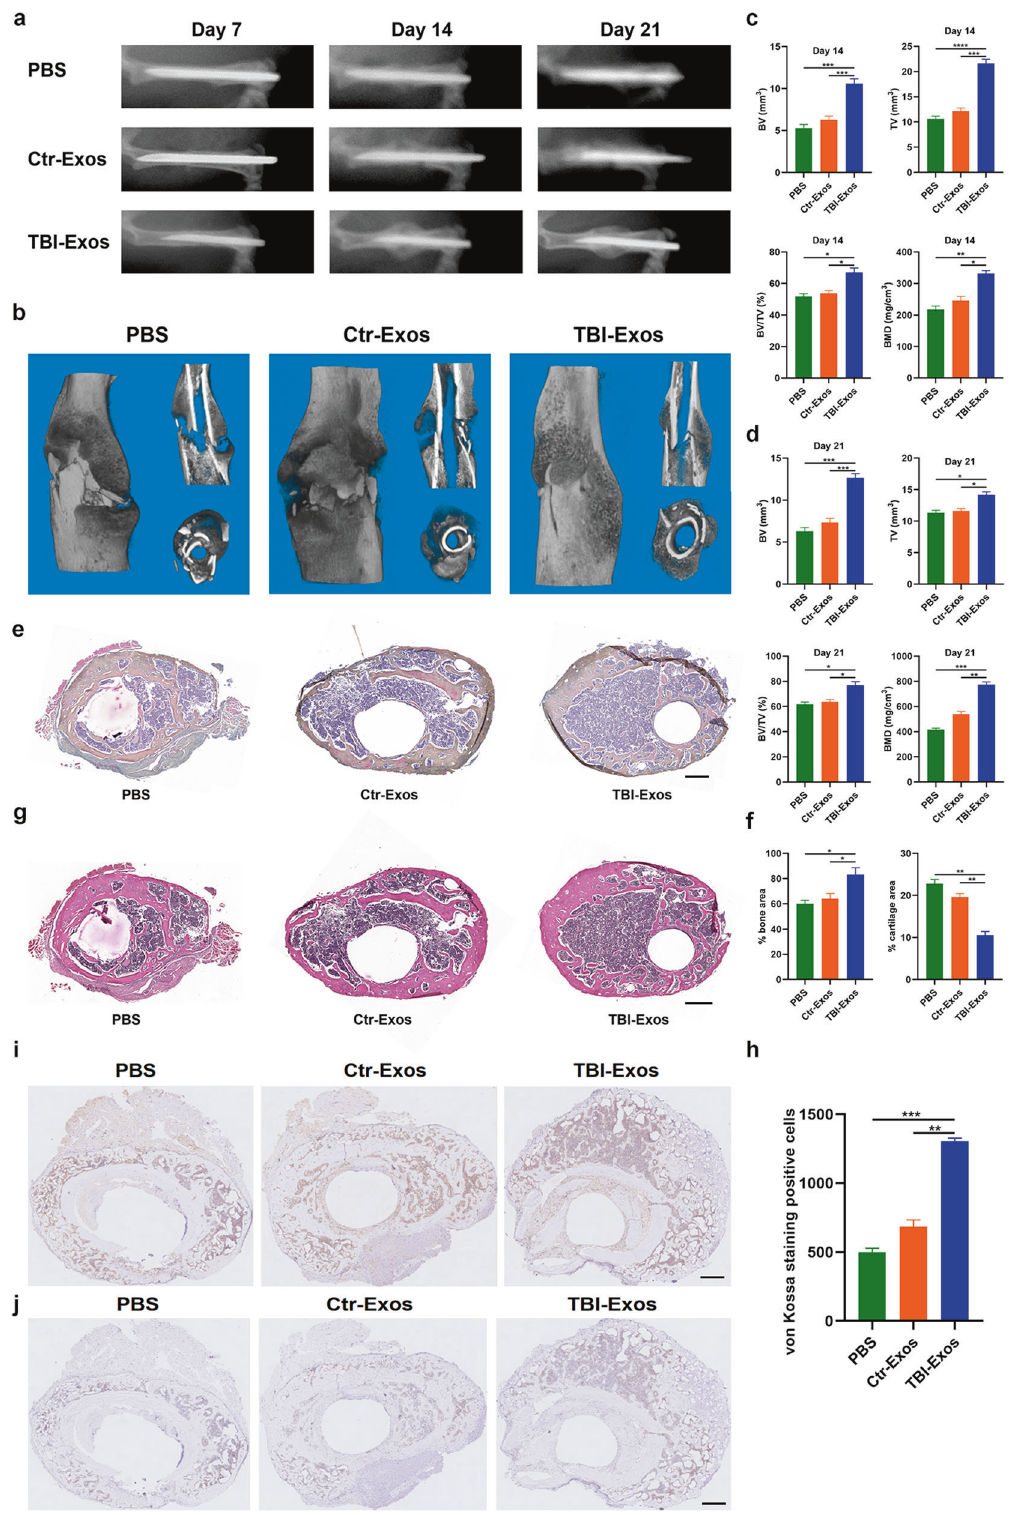
Fig. 2 TBI-Exos accelerate fracture healing in vivo. a , b The healing processes in the mouse model with different treatments were assessed by X-ray a and micro-CT analysis b . c , d The CTAnalyzer was used to measure the BV, TV, BV/TV and BMD results of mice on Day 14 and Day 21 after fracture. e – h The ABHEOG and Von Kossa staining results of mice on Day 21 after fracture, scale bar: 200 μ m. i , j , CD31 and Ki67 immunohistochemistry of the callus in different groups, scale bar: 500 μ m. Data are the mean ± SD of triplicate experiments. * p < 0.05, ** p < 0.01, *** p <